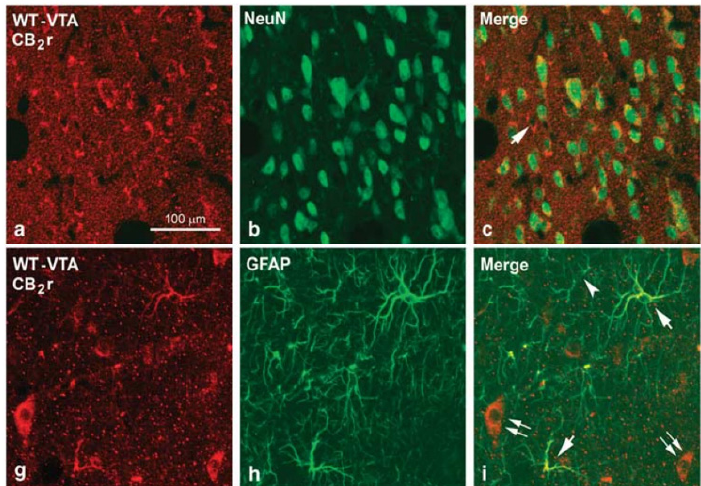
Figure 1. Confocal photomicrographs showing immunolabeling for CB2 receptors (CB2r), neuronal nuclei (NeuN) and glial fibrillary acidic protein (GFAP) in the ventral tegmental area (VTA) and the nucleus accumbens (NAcc) of wild-type (WT) mice. Double labeling CB2r-NeuN (yellow cells in c) in the VTA and the NAcc and CB2r-GFAP (yellow cells in i) in the VTA indicates the existence of CB2r in neurons and astrocytes. Image adapted from Aracil-Fernandez et al. Neuropsychopharmacology (2012) 37,